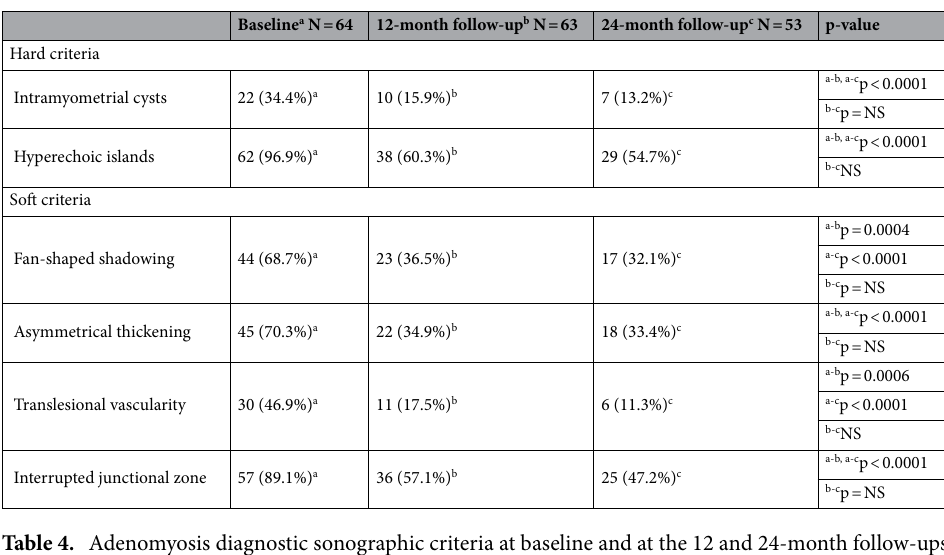
Table 4. Adenomyosis diagnostic sonographic criteria at baseline and at the 12 and 24-month follow-ups. Results expressed as number and percentage. NS not significant.